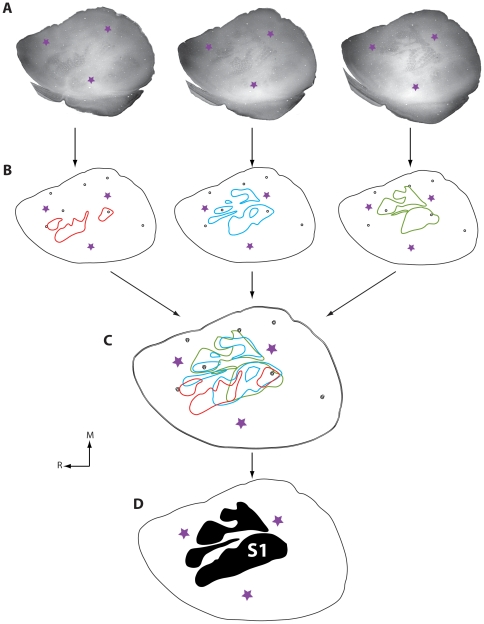
Reconstruction of architectonic borders.A) Photomicrographs are consecutive sections of CO-stained tissue each containing portions of the architectonic boundaries of the primary somatosensory area. Blood vessels appear as small white circles, and the primary sensory areas are visible as more darkly staining areas. The purple stars in all figures represent location of fluorescent probes placed in the brain during electrophysiological recording experiments and marked on the digital photograph of the brain, along with recording sites. By aligning these probes with digital images containing electrophysiological recordings, functional maps of S1 can be accurately matched to cortical architecture. B) The outer boundary of the cortical sheet and blood vessels are drawn along with portions of S1 (red, blue and green lines) that are visible in each section. C) By aligning blood vessels, data from all sections are superimposed onto a single section, and then a single comprehensive reconstruction of architectonic boundaries is drawn (D). In all sections, medial is to the top and rostral is to the left.